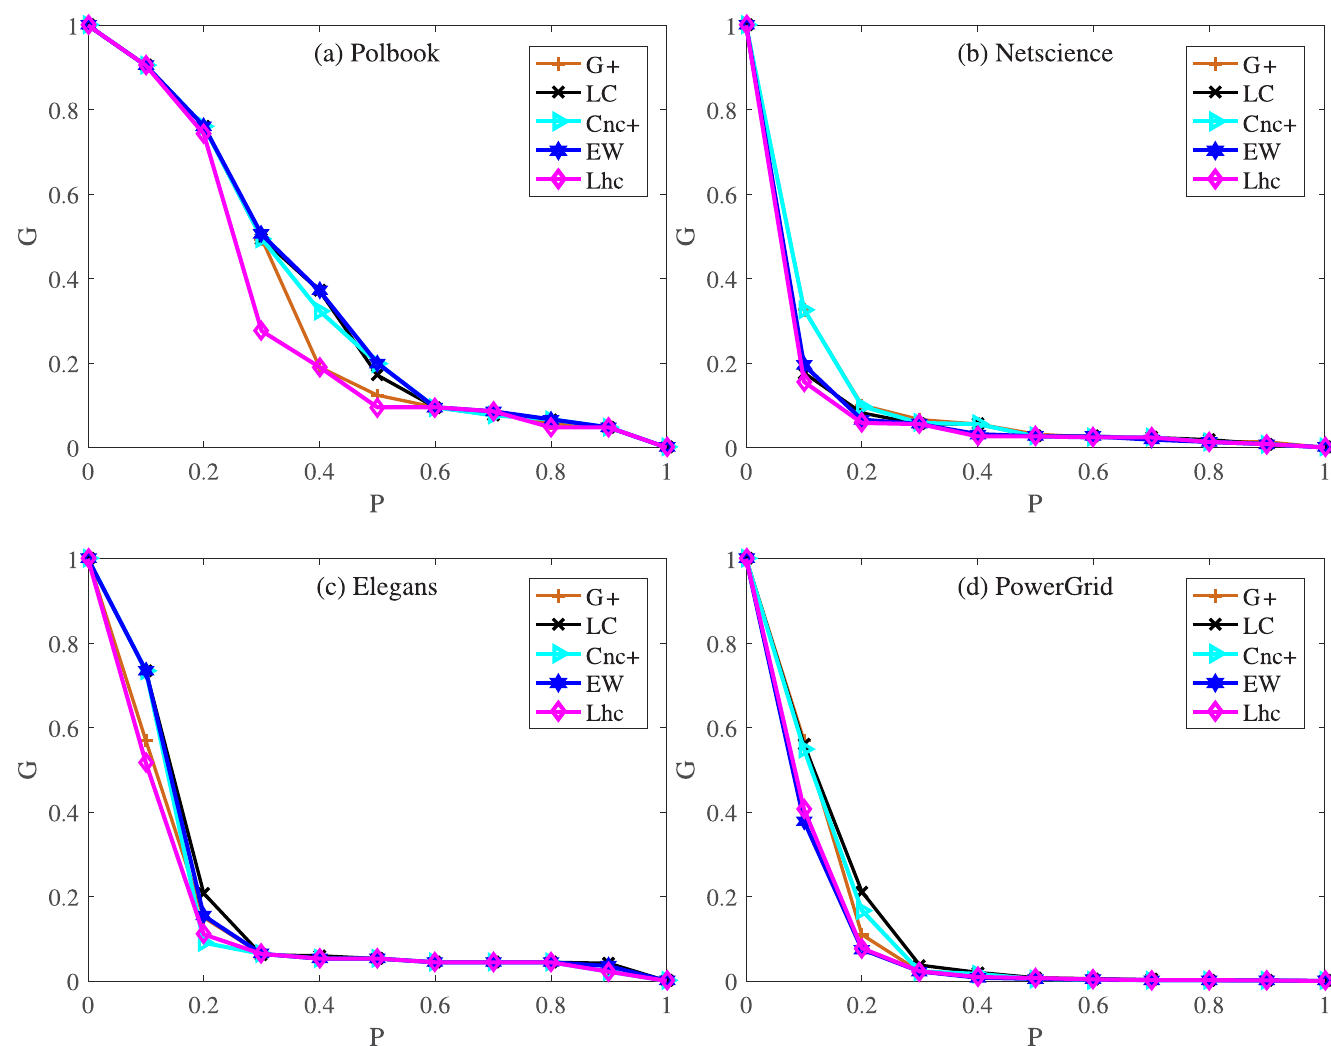
Fig 7. The change of connectivity part after the remove of top influence nodes. (a)-(d): Lhc are compared with other four semi-local methods including LC, Cnc + , EW and G + on the networks of Polbook, Netscience, Elegans and PowerGrid